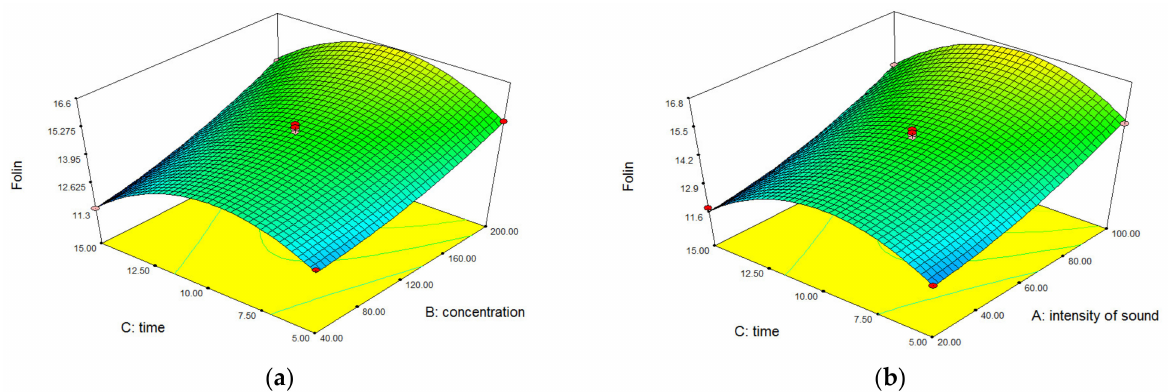
Figure 4. Three-dimensional figures of the interactive effects of 3 factors (intensity, concentration, time). Response surface plot representing the effect of: ( a ) concentration and time factors on Folin–Ciocalteau extraction; ( b ) sound and time factors on Folin–Ciocalteau